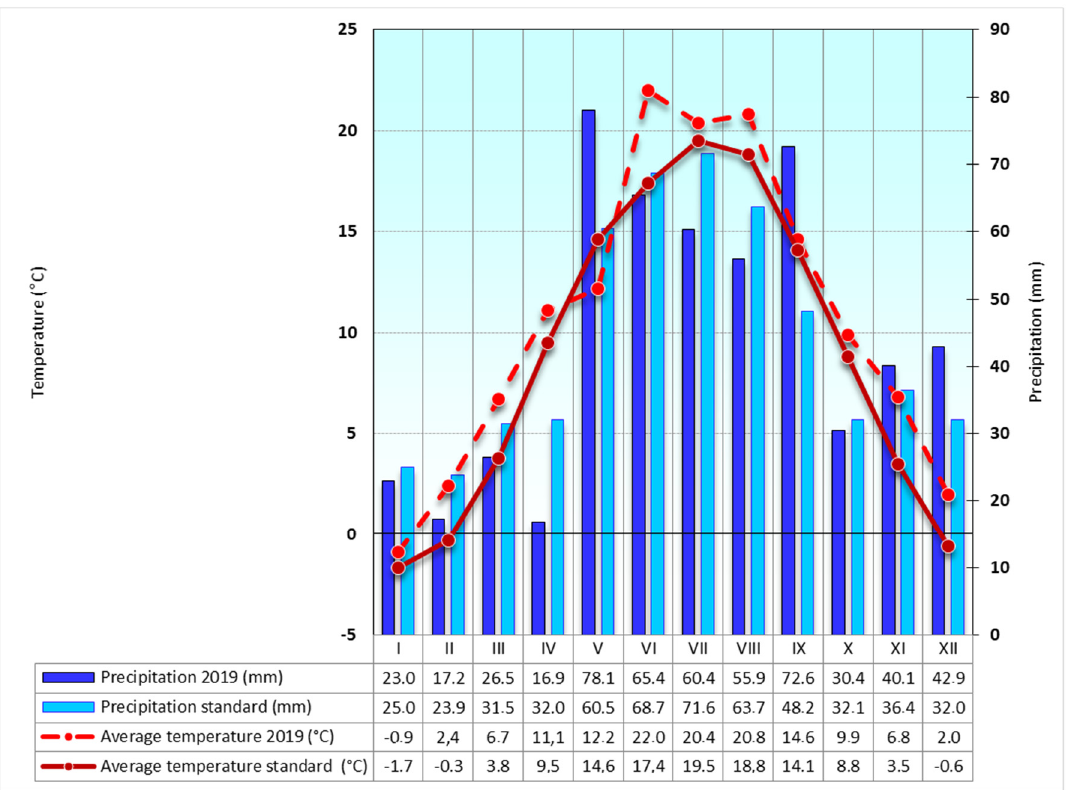
Figure A2. Weather conditions at the Troubsko field experimental station, 2019—average monthly temperatures and mean annual precipitation amounts for long–term standard (1981–2010).